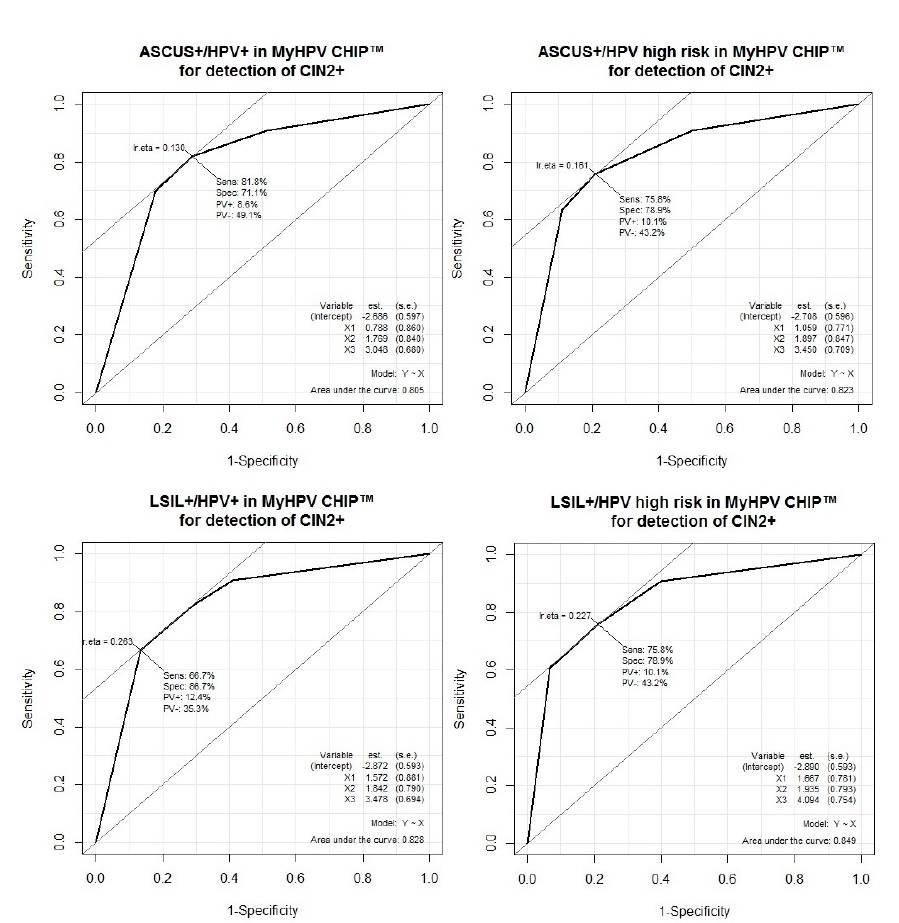
Figure 1. ROC (receiver operating characteristic) curve of cytology and MyHPV CHIP™ for the detection of CIN2 or worse: The AUC (area under the curve) of Cytology (ASCUS or worse)/MyHPV CHIP™ all types is 0.805. The AUC of Cytology (ASCUS or worse)/MyHPV CHIP™ high-risk is 0.823. The AUC of Cytology (LSIL or worse)/MyHPV CHIP™ all types is 0.828. The AUC of Cytology (LSIL or worse)/MyHPV CHIP™ high-risk is 0.849.